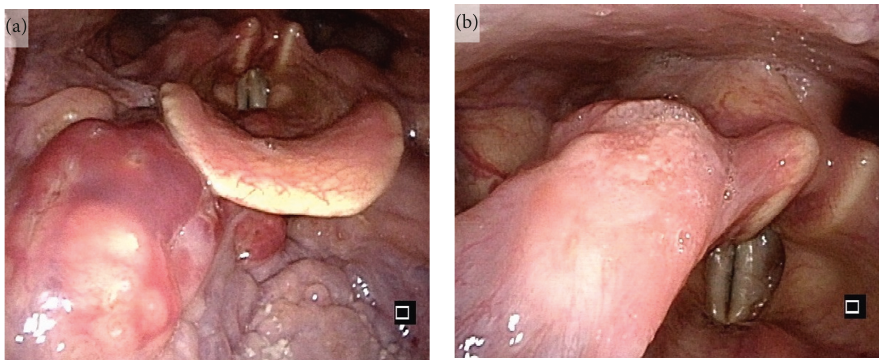
Figure 1: Pharyngolaryngoscopy. A superficial, smooth tumorous lesion with red color is observed (a). A protruding lesion with atypical blood vessel formation in the mucosa surface is also observed (b).